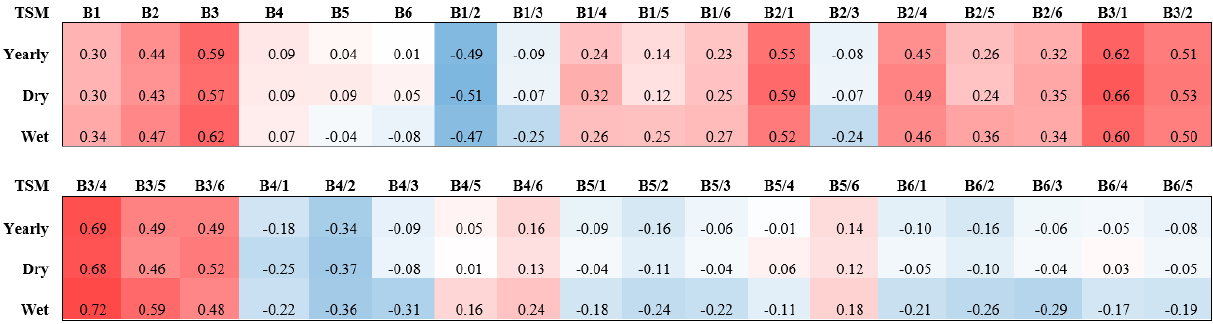
Figure 4 . Correlation matrix of TSM and Himawari-8 bands. Features that are highly correlated to TSM are shown in dark red and dark blue colors such as band ratios of Band 3 and Band